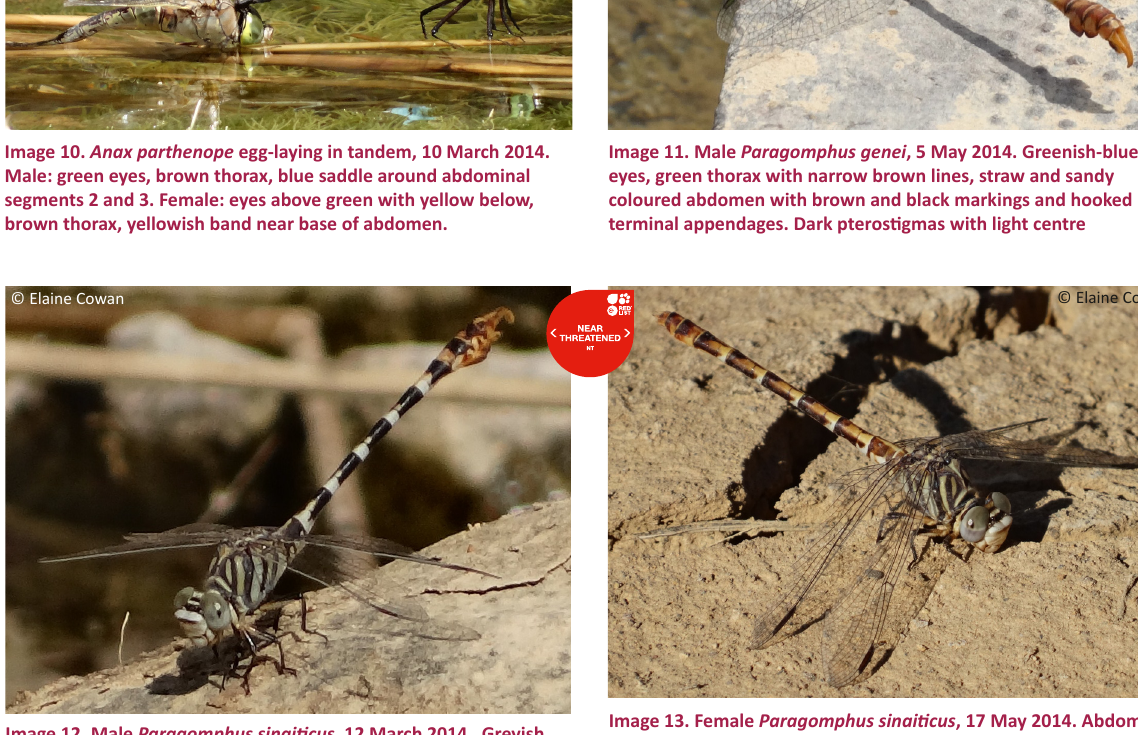
Image 12. Male Paragomphus sinaiticus , 12 March 2014. Greyish eyes, pale frons, grey thorax with black stripes, black and whitish banded abdomen with hooked terminal appendages.